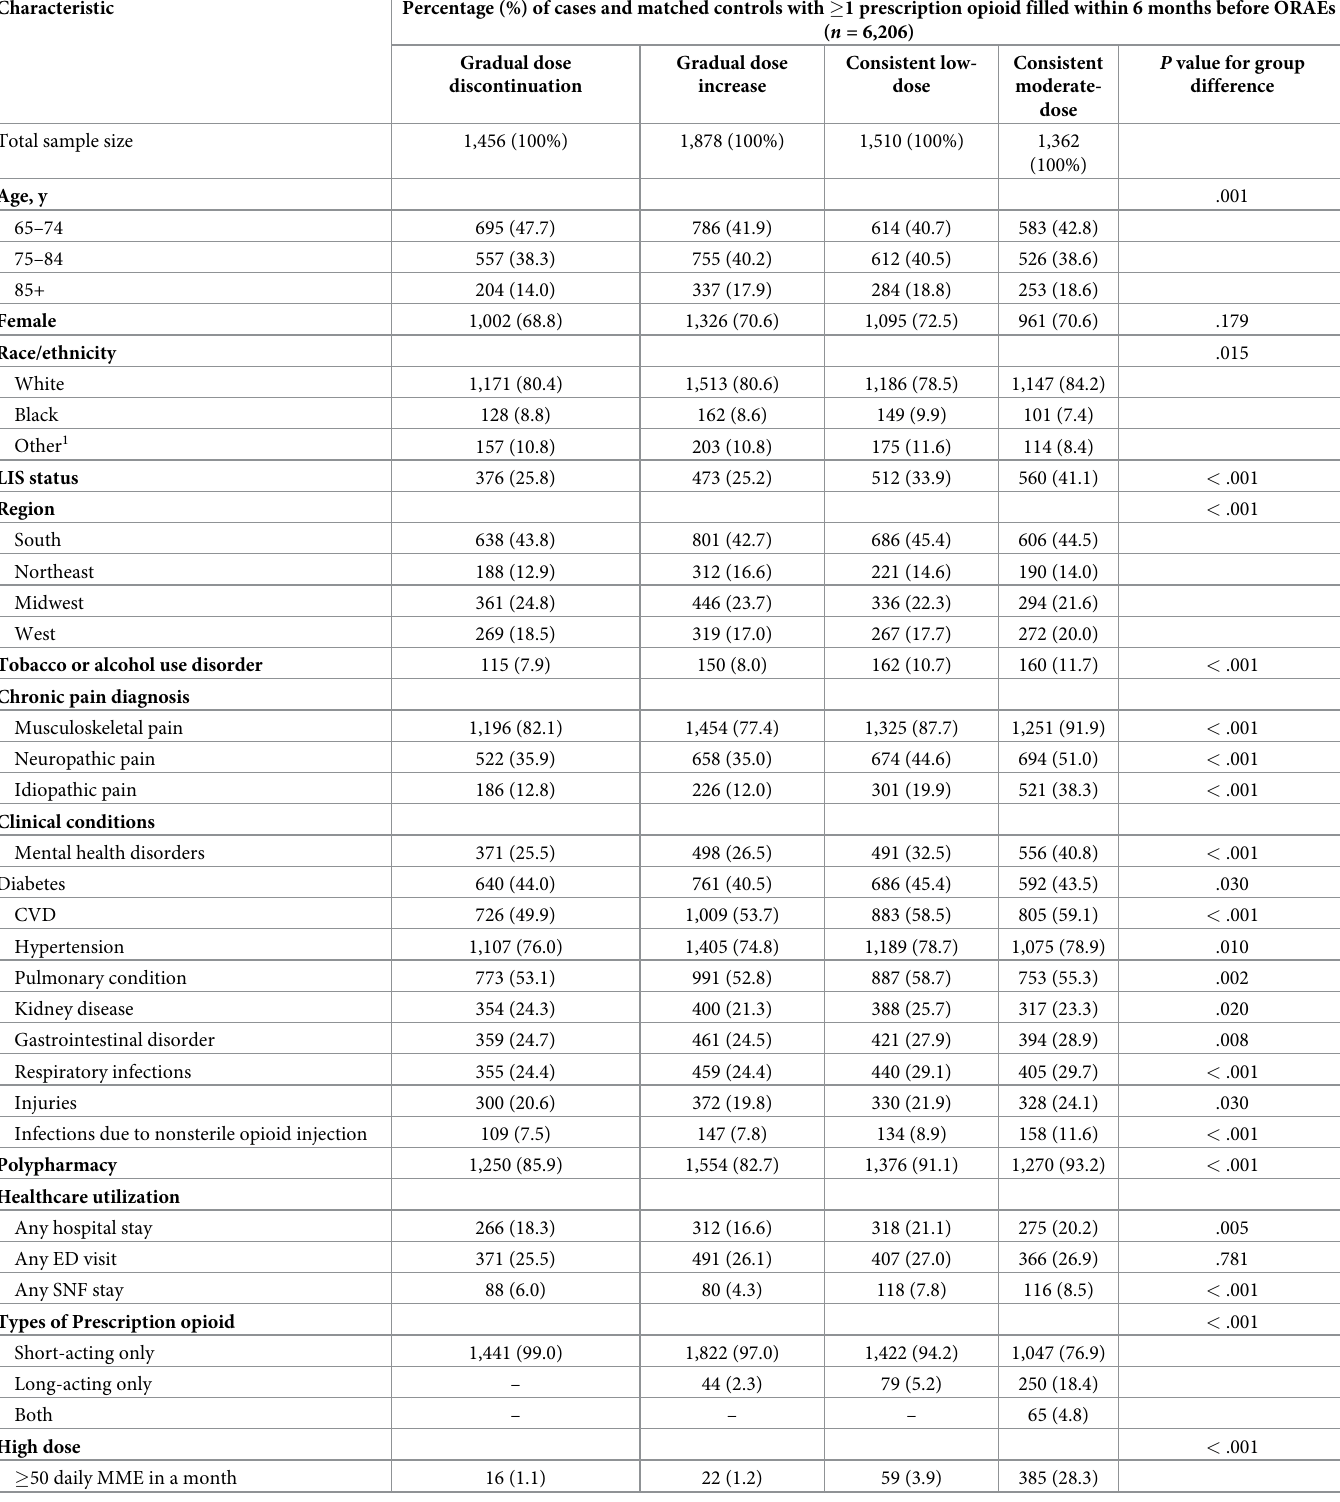
Table 2. Characteristics of defined trajectories of prescribed opioid dose within 6 months before an incident diagnosis of ORAE or matched controls.